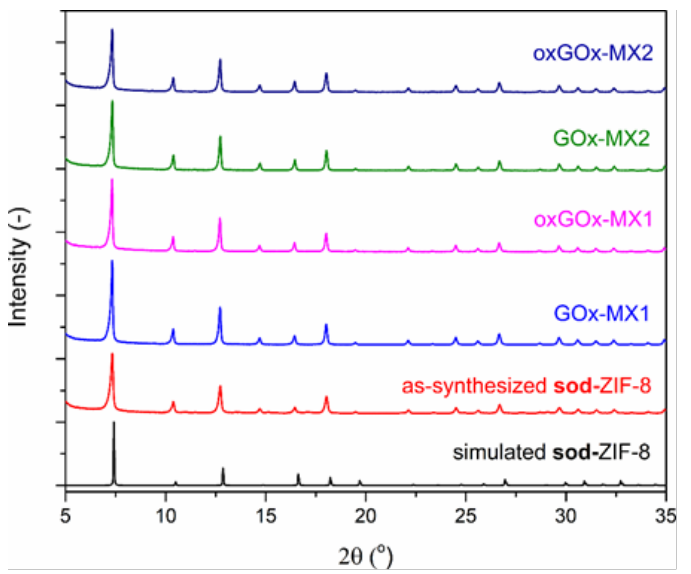
Figure 2. Simulated PXRD pattern of sod -ZIF-8 (black) and experimental PXRD patterns of as-synthesized sod -ZIF-8 (red), GOx-MX1 (blue), oxGOx-MX1 (magenta), GOx-MX2 (green), and oxGOx-MX2 (dark blue).